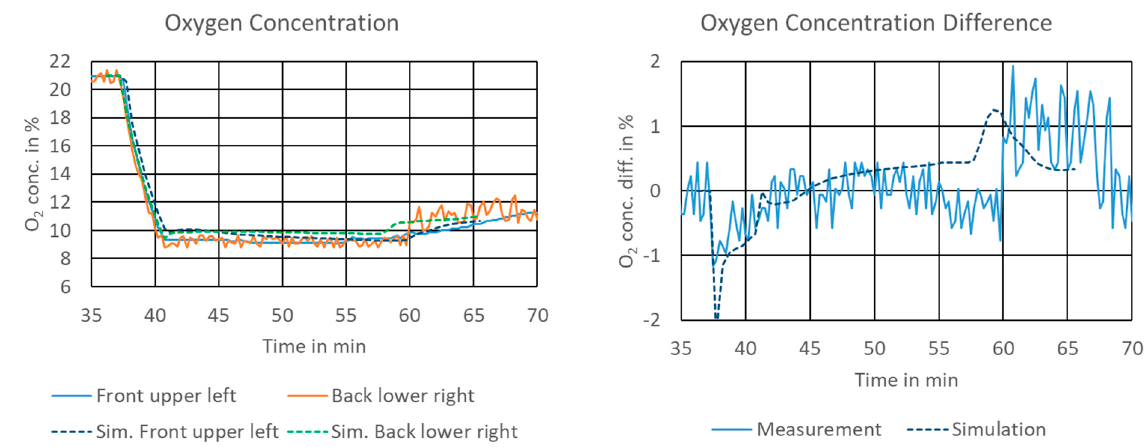
Figure 8. Left : Comparison of measured (bold) and simulated (dotted) oxygen concentrations. Right : Oxygen concentration difference between the extremities.